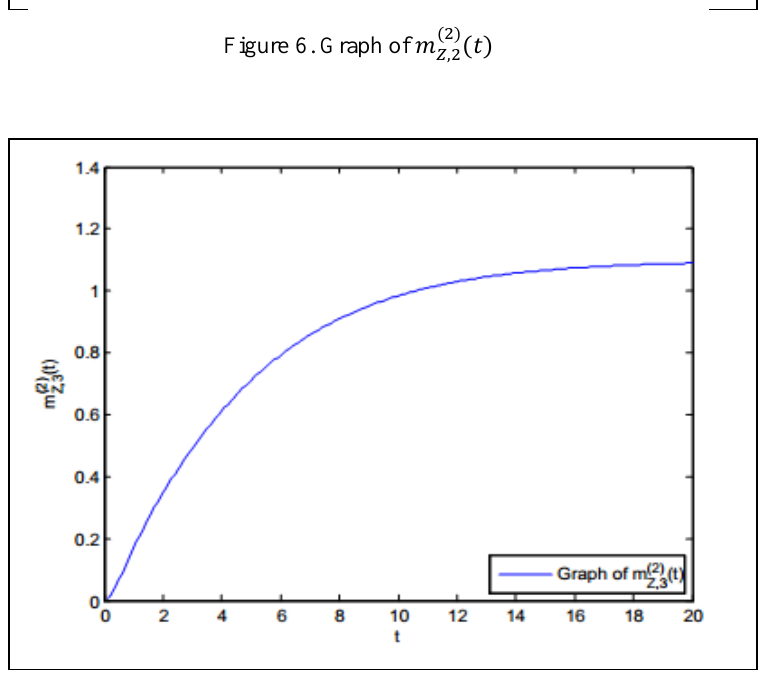
Figure 7. Graph of 𝑚 𝑍,3(2)